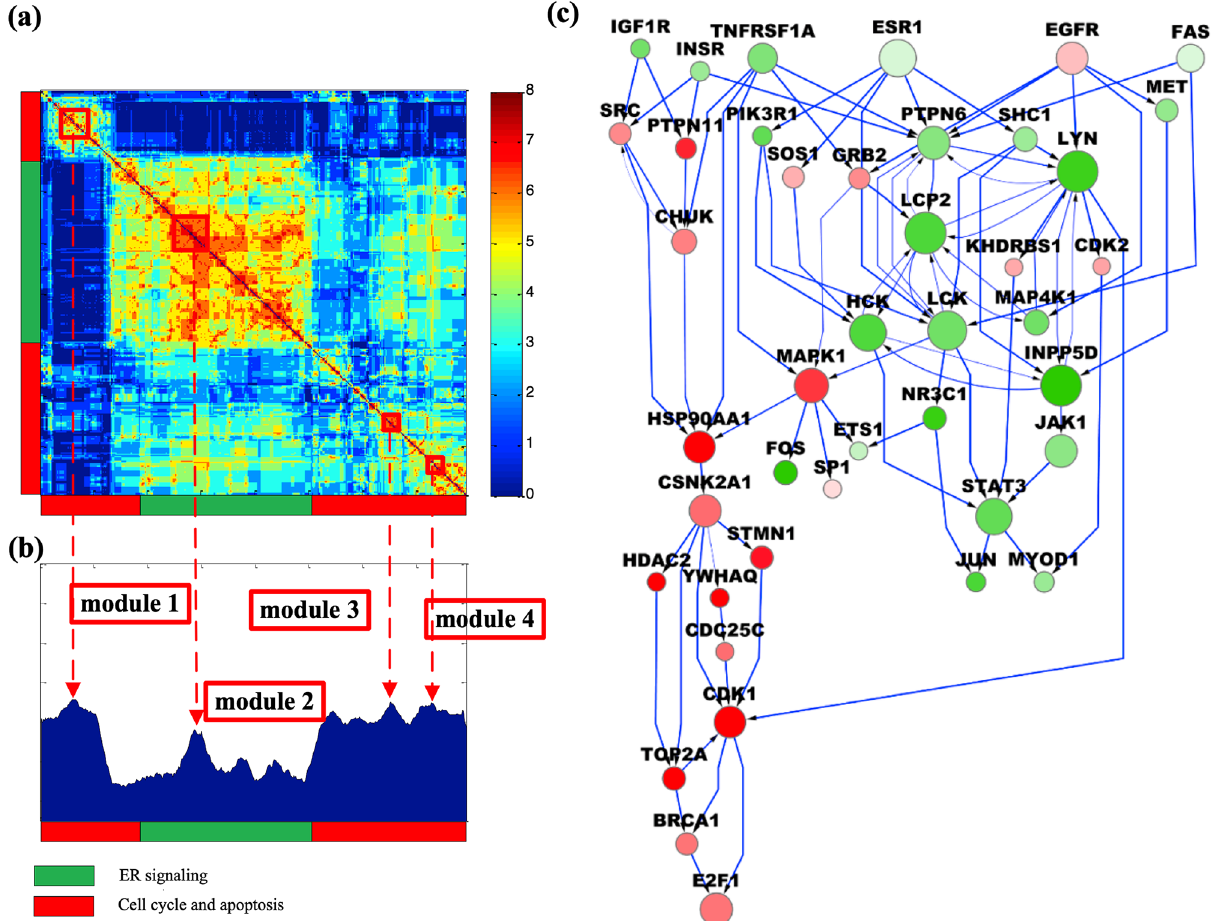
Figure 5. Pathway modules and crosstalk identified by IMPALA using the Symmans data. ( a ) Pathway clustering based on gene similarity and gene functions in different clusters reveal the functional diversity of IMPALA-identified pathways. ( b ) Distribution of sampling frequency of pathways with peaks corresponding to major pathway clusters in (a). Four pathway modules were identified. ( c ) A combined pathway network consisting of the four modules with